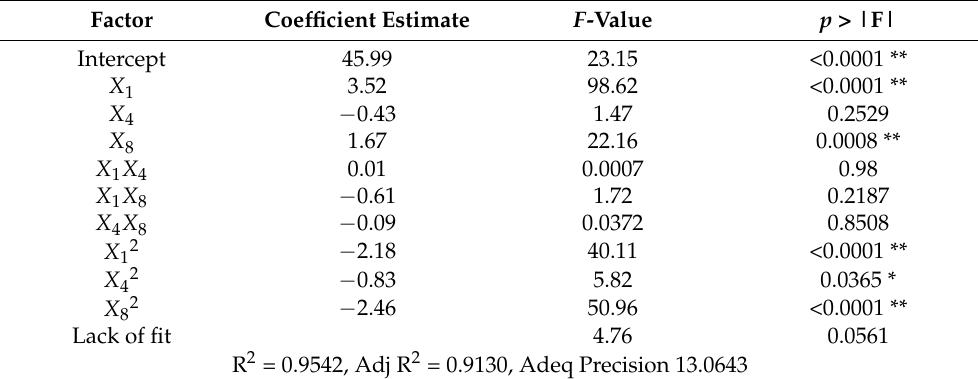
Table 5. ANOVA analysis for quadratic regression model of the yield of M-EPS in central composite design. Factor Coefficient Estimate F -Value p > |F|